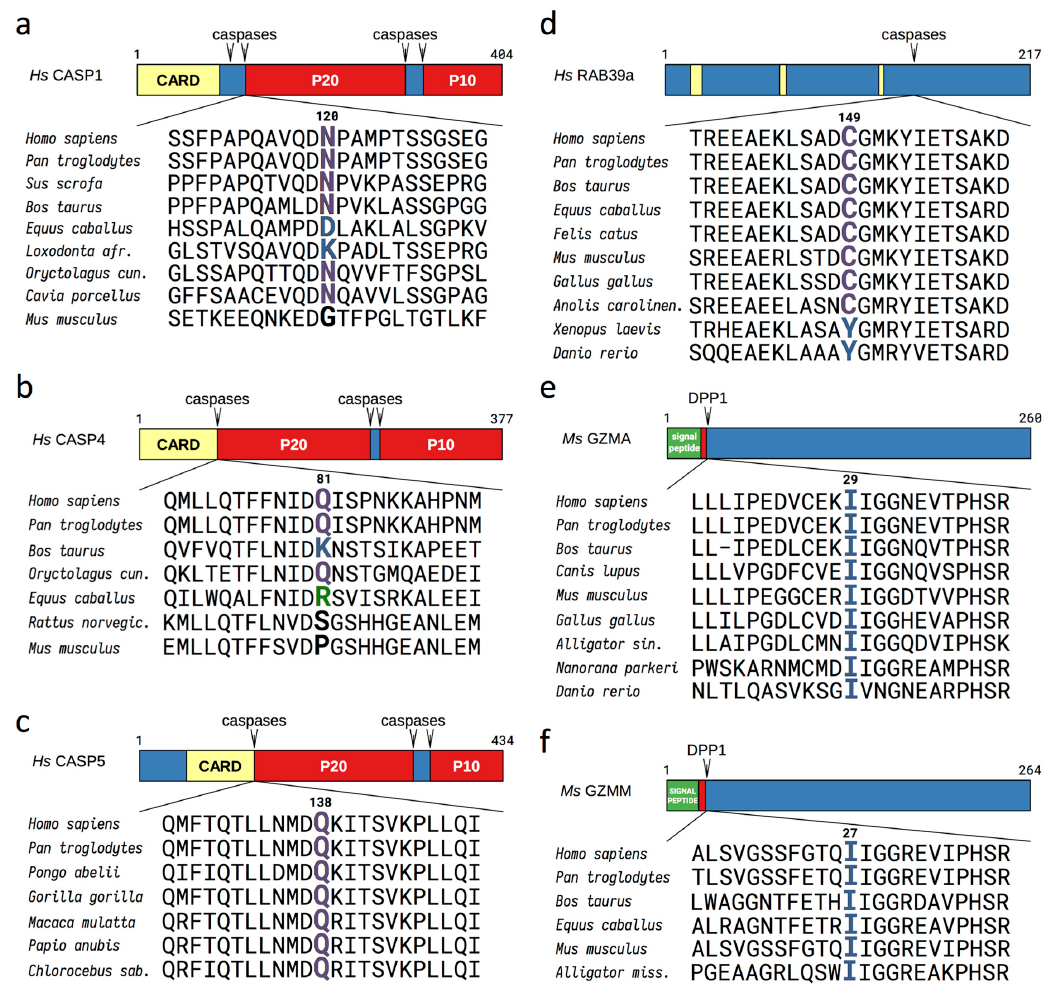
Figure 2. Evolutionary conservation of the cleavage sites and destabilizing P1 ′ residues in the proinflammatory protein fragments Asn-CASP1 ( a ), Gln-CASP4 ( b ), Gln-CASP5 ( c ), Cys-RAB39a ( d ), Ile-GRZA ( e ), and Ile-GRZM ( f ). These fragments have been shown, in the present work, to be short-lived substrates of the Arg / N-degron pathway (Figure 3). These proapoptotic fragments are generated by autoprocessing, by caspases, or by other endopeptidases. Cleavage sites are indicated by arrowheads. The indicated residue numbers, including the numbers of the P1 ′ residues (larger letters), are of the human or mouse versions of the cited proteins. Approximate locations and names of specific protein domains are indicated as well. These fragments are described in the Supplementary Results.